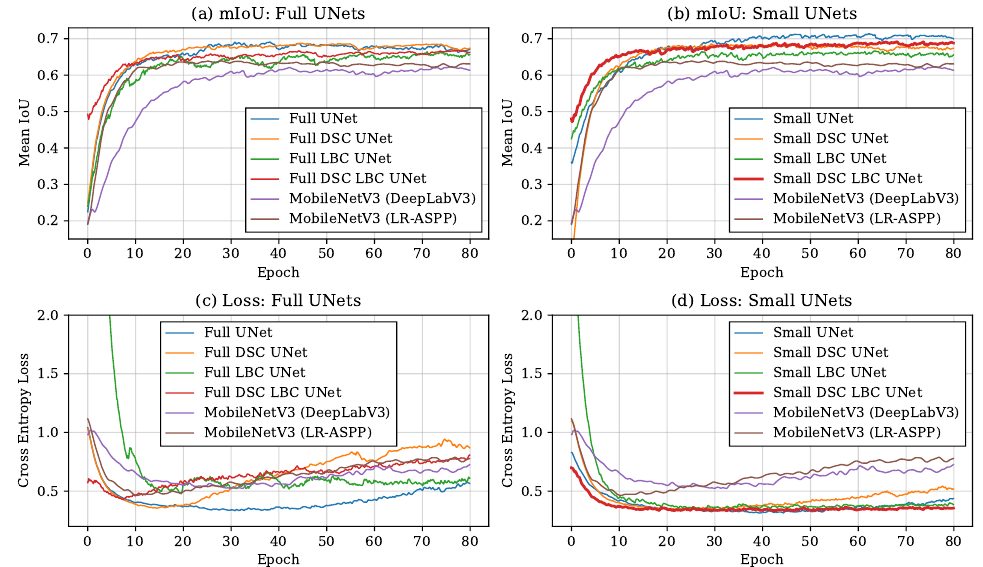
Figure 6. Mean IoU of the validation set after 80 training epochs is shown for the Full UNets ( a ) and Small UNets ( b ). Cross entropy loss for the validation set is also shown over 80 epochs for the Full UNets ( c ) and Small UNets ( d ). Note that the MobileNets are shown in all chats for the sake of comparison. The data in all of the charts has an exponential moving average applied with a smoothing factor or 0.95 to filter noise caused by a small validation